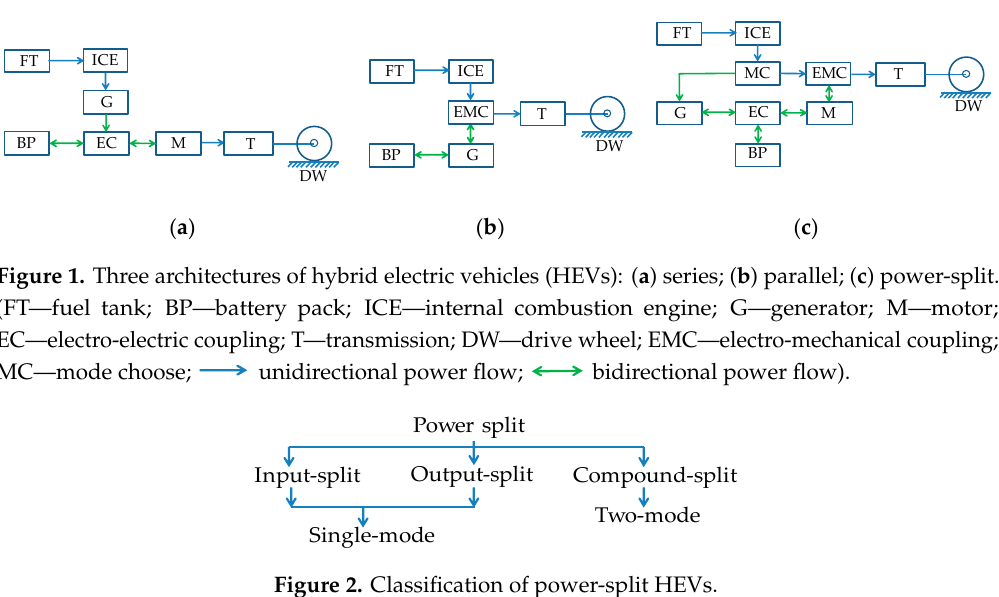
Figure 2. Classification of power-split HEVs.